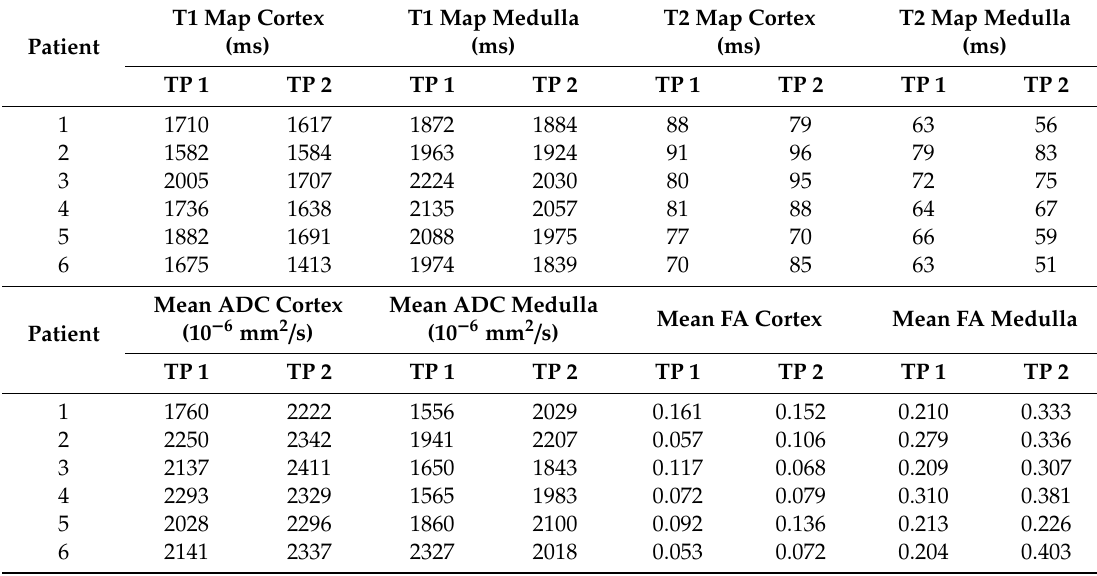
Table 3. Data on the longitudinal